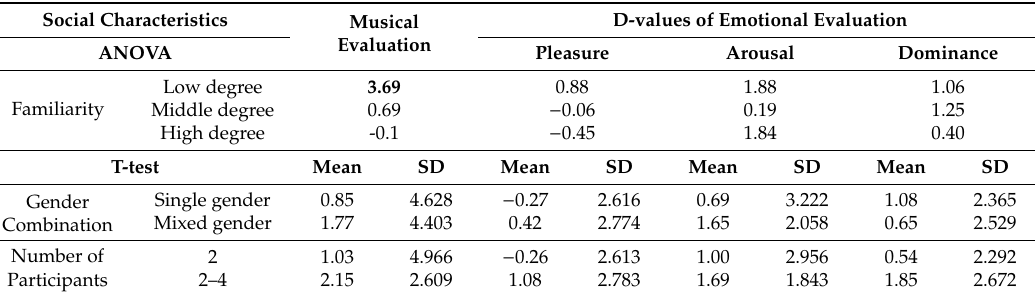
Table 4. Musical and Emotional Evaluations in terms of Social Characteristics.